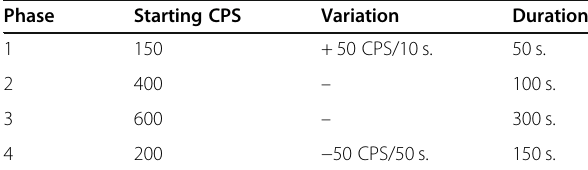
Table 1 IMS1, Cycle 1 Configuration Table 2 IMS1, Configuration Variations, Cycles 2 – 6